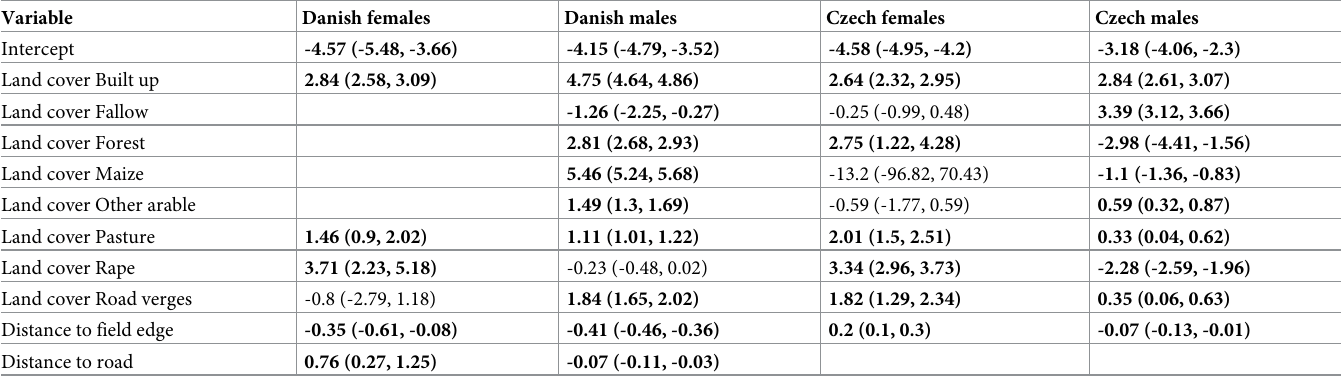
Table 2. Analyses of habitat selection by little owls.